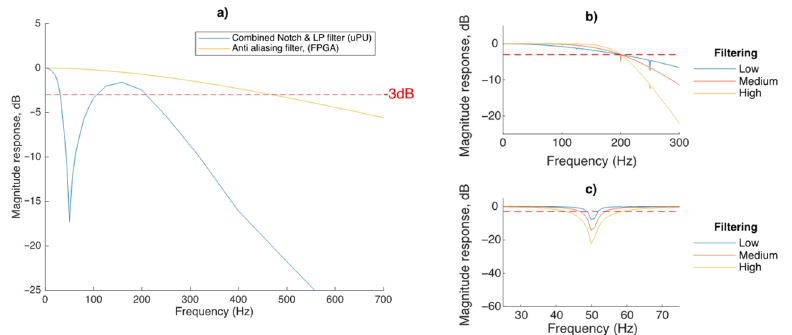
Figure 2. ( a ) Hardware, ( b ) software low pass, and ( c ) software notch filter FRA.